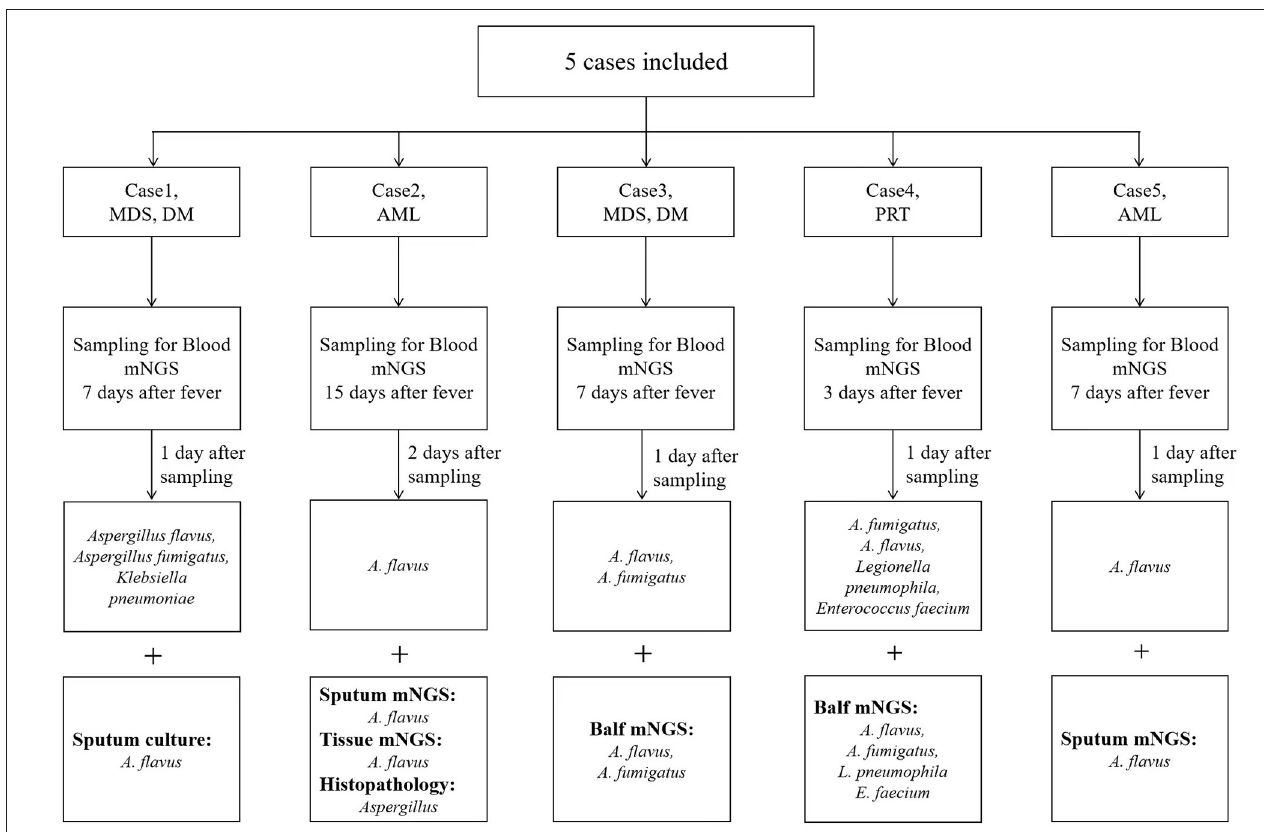
FIGURE 1 | The diagnostic process of 5 cases.